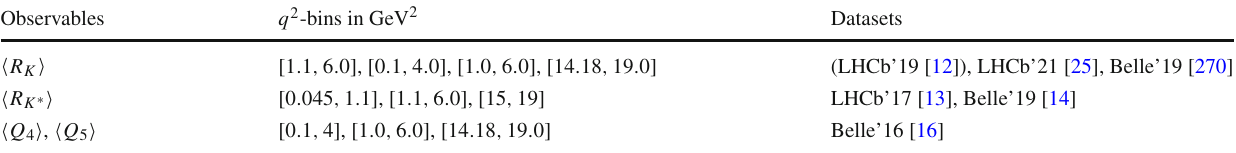
Table 8 Datasets of observables in B → K ( ∗ ) (cid:4)(cid:4) decays sensitive to LFU violation Observables q 2 -bins in GeV 2